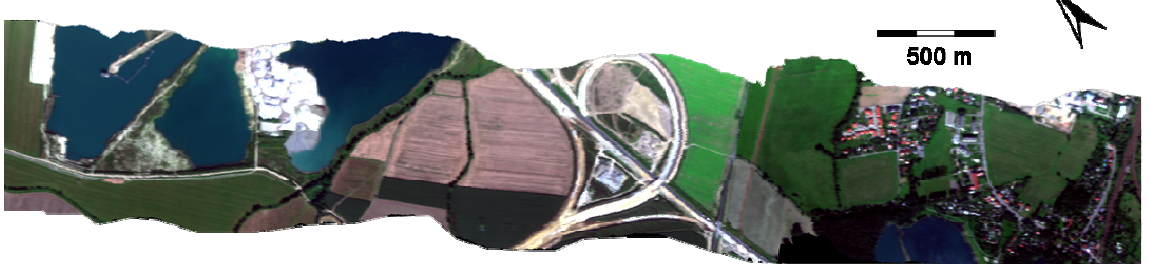
Figure 13. Geometrically and radiometrically corrected AVIS-2 image stripe acquired on August 30th 2005